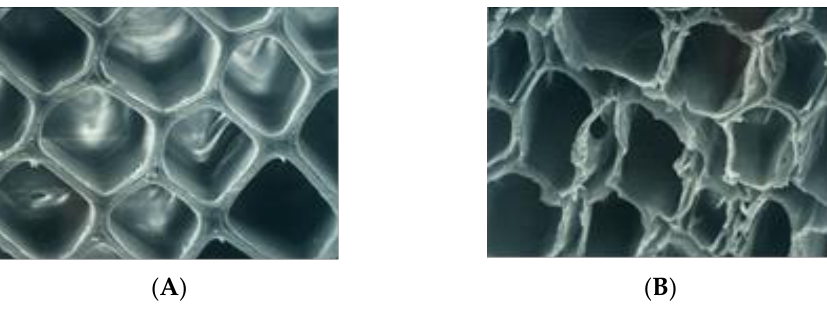
the photo degradation occurs preferentially in this area of the wood surface. This is par- exposure. UV exposure.